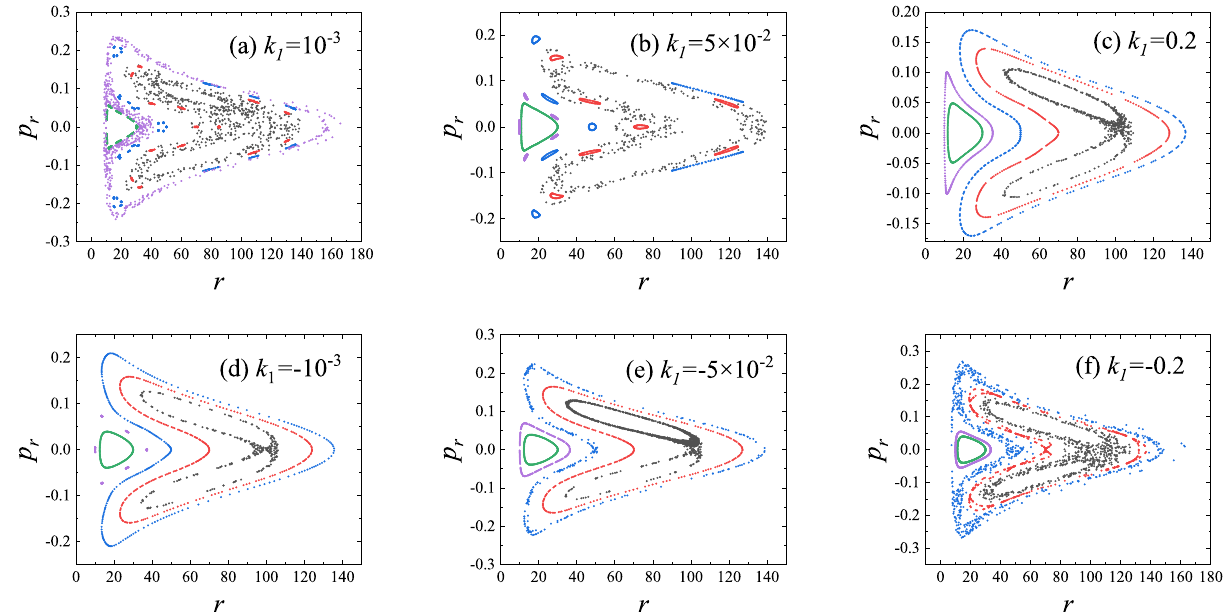
Figure 9. Same as Figure 7, but k 0 in Figure 7 is replaced with k 1 . ( a – c ) : k 0 = 5 × 10 − 4 . ( d – f ) : k 0 = 10 − 4